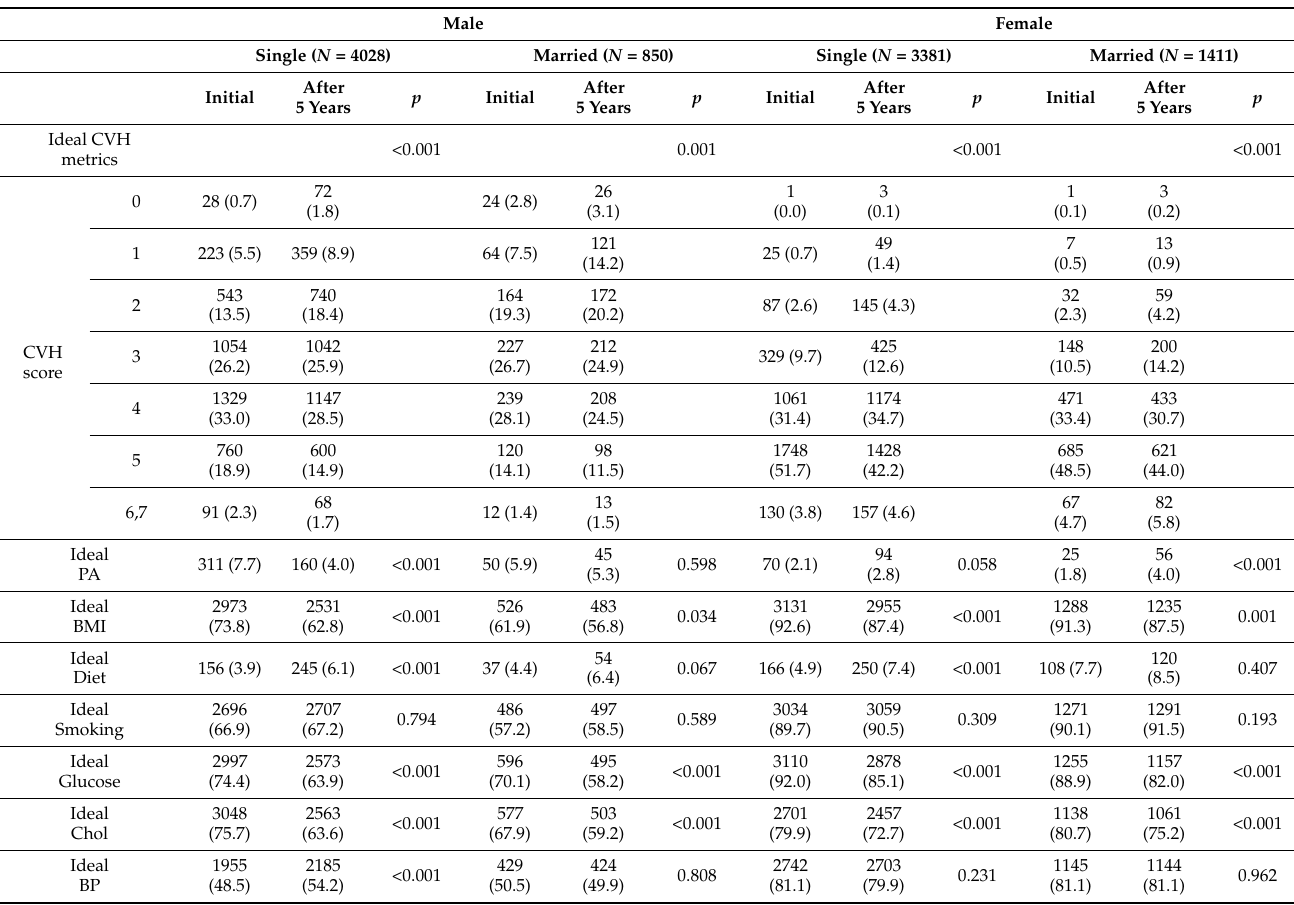
Table 4. Differences in ideal cardiovascular health metrics among the participants divided by marital status after 5